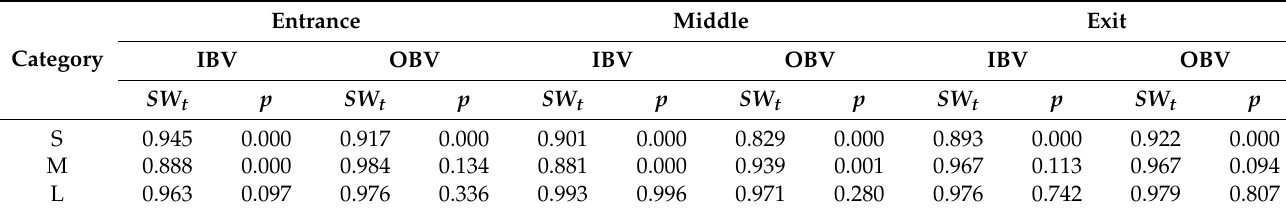
Table 3. Normal distribution test results.